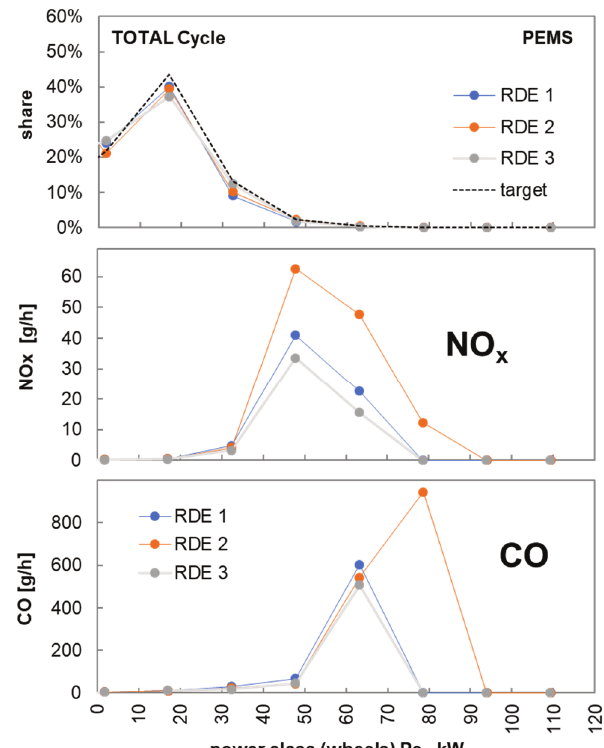
Fig. 13. Power binning results for 3 RDE-Measurements; Volvo